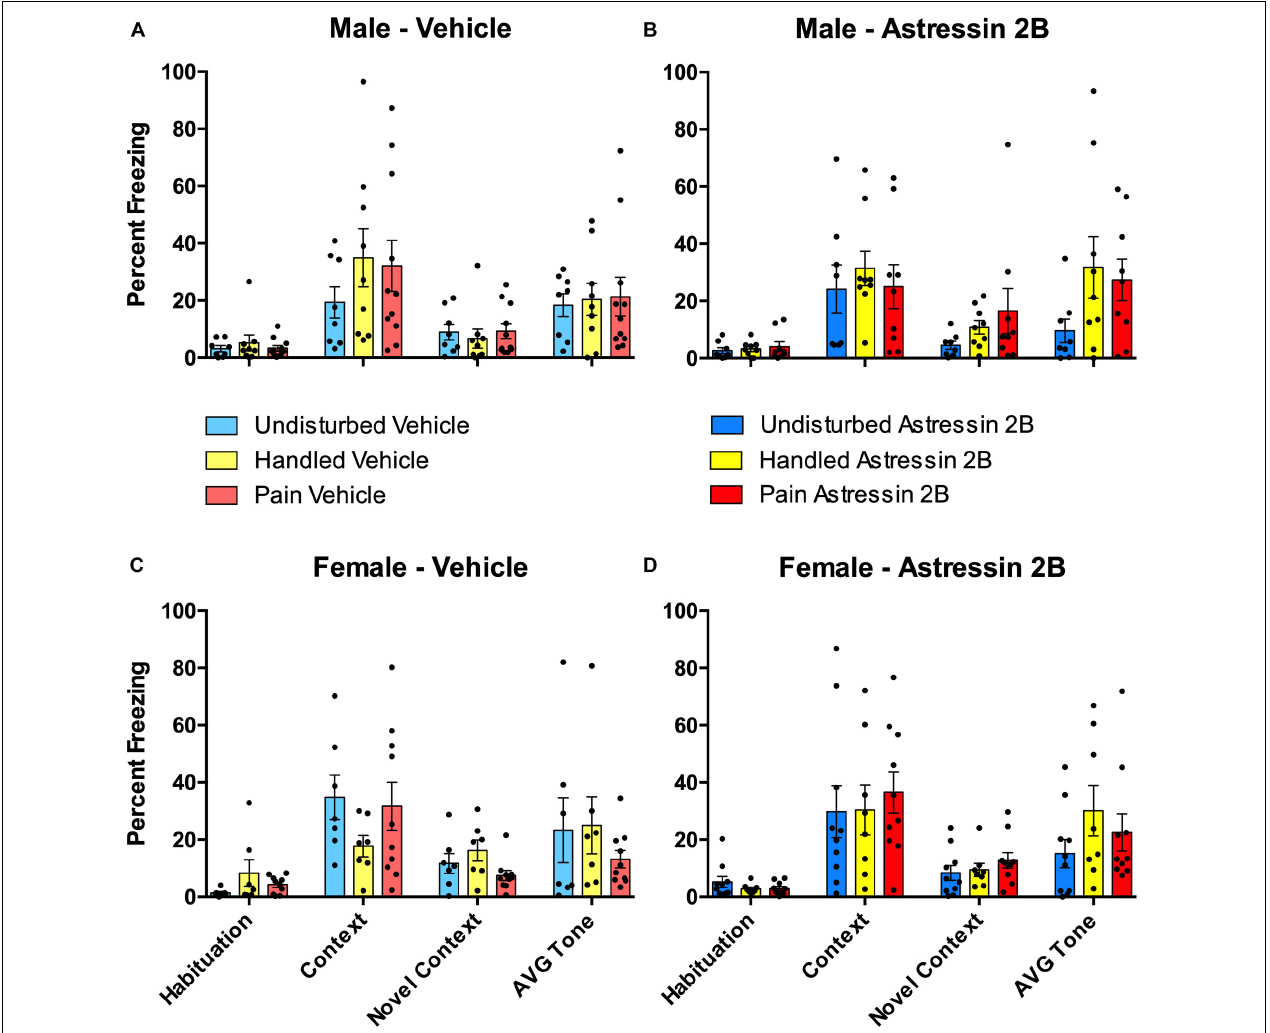
FIGURE 7 | Effects of Astressin 2B on percent freezing for rats during the four freezing variables (Habituation, Context, Novel Context, Average Tone) following fear conditioning in neonatally manipulated rats for Experiment 2. Top two panels represent male Undisturbed, Handled, and Pain rats with (A) vehicle-treated rats (Undisturbed—N = 8, Handled—N = 9, Pain—N = 11) and (B) Astressin 2B-treated rats (Undisturbed—N = 8, Handled—N = 9, Pain—N = 9). The bottom two panels represent female Undisturbed, Handled, and Pain rats with (C) vehicle-treated rats (Undisturbed—N = 7, Handled—N = 7, Pain—N = 10) and (D) Astressin 2B-treated rats (Undisturbed—N = 10, Handled—N = 8, Pain—N = 10). These results show that fear conditioning altered subsequent freezing but show no other significance of condition or drug treatment. Data are presented as means with error bars as ±